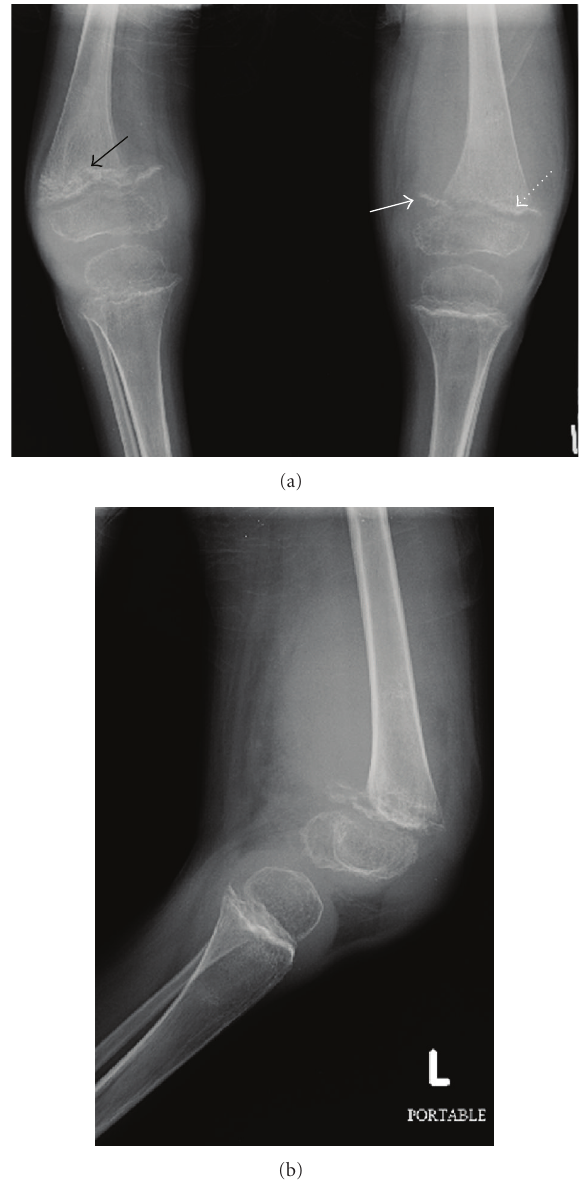
Figure 2: Anteroposterior (a) and lateral (b) X-rays of the knees showing varus deformity. Visible abnormalities include ground glass osteoporosis, thinning of the cortices, lucencies at metaphysis (Trummerfeld zone, black arrow), small corner fractures (Pelkan’s spur, solid arrow), and dense zone of provisional calcification in the physis (White line of Frankel, dotted arrow).